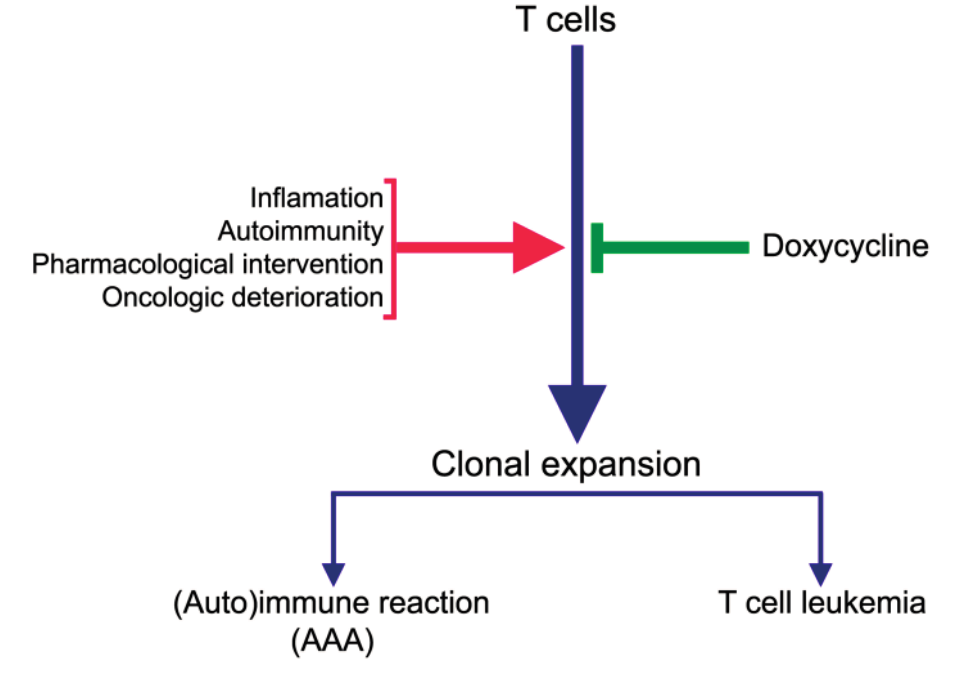
Figure 1. Schematic presentation of the possible causes of clonal expansion of T cells and the inhibition of